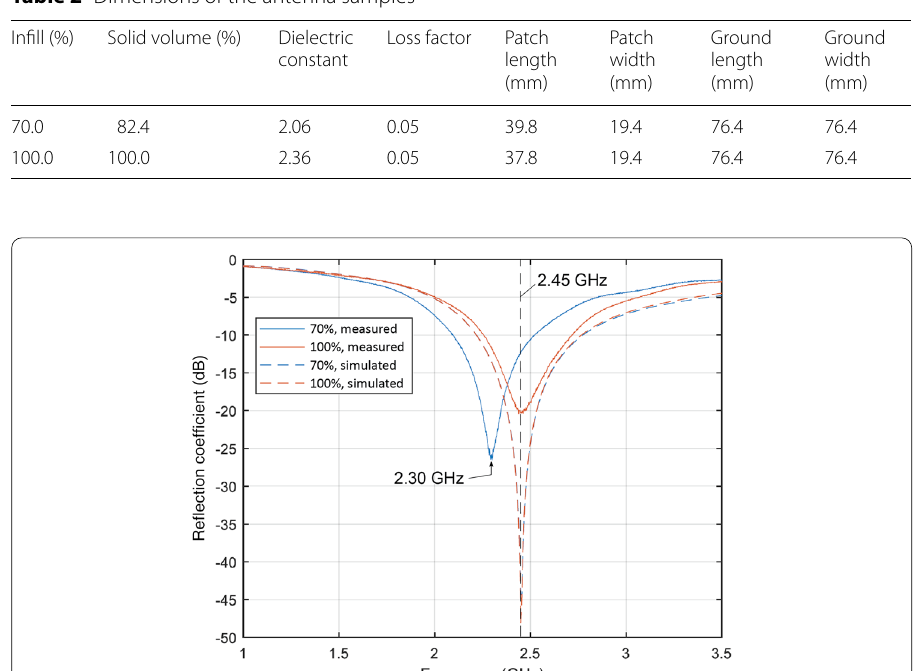
Fig. 7 Simulated and measured reflection coefficients of the 100%- and 70%-infill